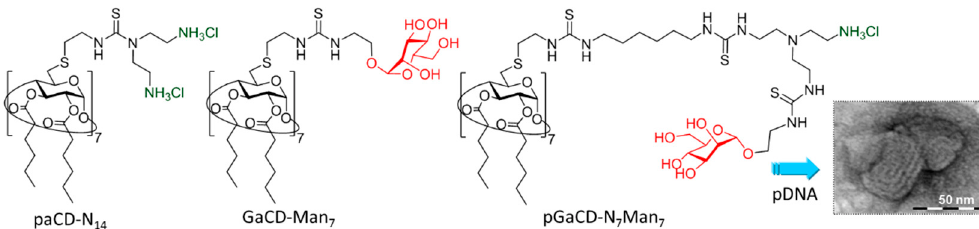
Figure 13. Structures of the polycationic amphiphilic β CD derivative paCD-N 14 (14 cationizable primary amines), the glycoamphiphilic β CD derivative GaCD-Man 7 (neutral; 7 mannosyl residues) and the polycationic glycoamphiphilic β CD derivative (7 cationizable primary amines and 7 mannosyl residues) reported by García Fernández and coworkers [156]. A representative image at high magnification of the CDplexes obtained from the latter and the luciferase-encoding plasmid DNA (pDNA) pTG11236 (5739 bp) is also shown. Adapted with permission from Reference [156]. Copyright 2011 Elsevier.